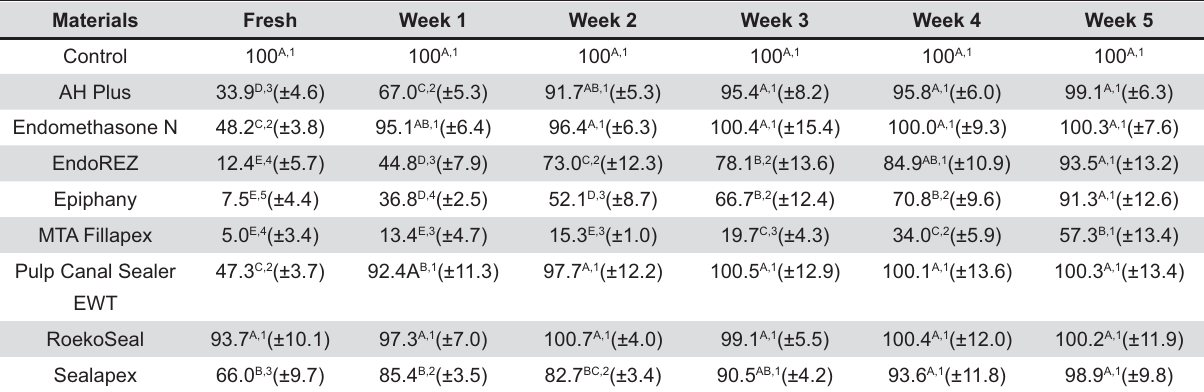
Table 1- Succinate dehydrogenase activities exhibited by 3T3 cells in the presence of different root canal sealers